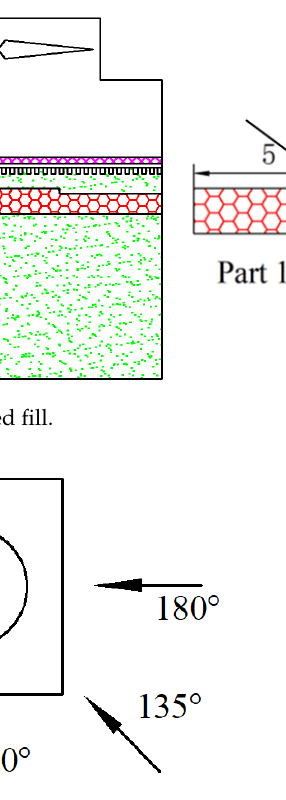
Figure 1. Structural sketch of the SIDCT. ( a ) Sketch of the measured SIDCT; ( b ) Working principle of the SIDCT.